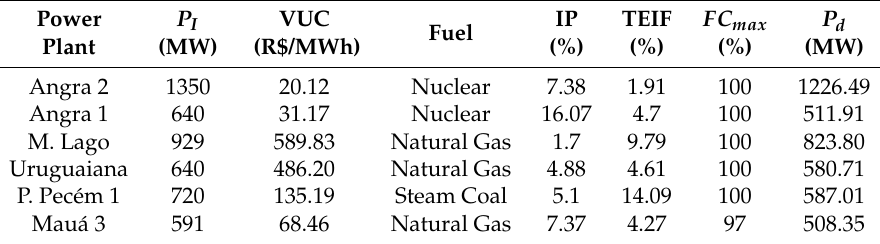
Table 7. Thermoelectric plants used in the proposed methodology.